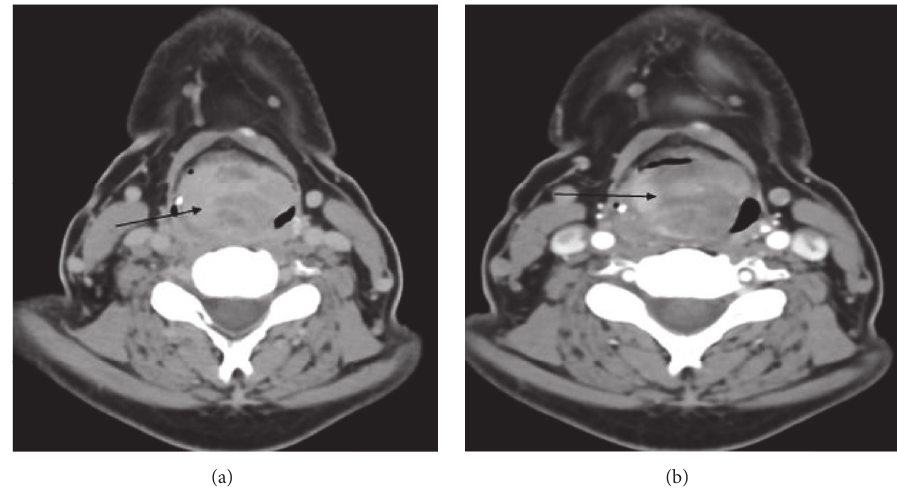
Figure 2: (a) Plain CT scan of the neck showing soft tissue mass at the region of epiglottis with tiny specks of calcifications in the periphery. (b) Postcontrast image showing heterogenous enhancement.